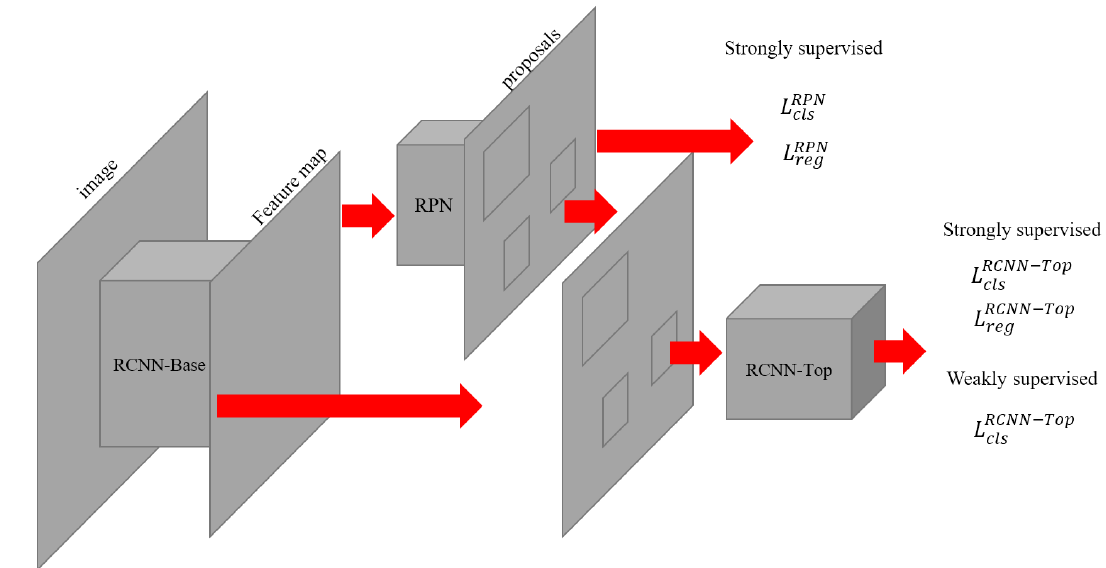
Figure 1. Illustration of the dataflow in the presented model. All of the four losses are used when training with D strong images, while only the classification loss in RCNN-top is calculated for D weak images. Refer to [11] and Section 2.3 for detailed methods for choosing target RoIs and calculating